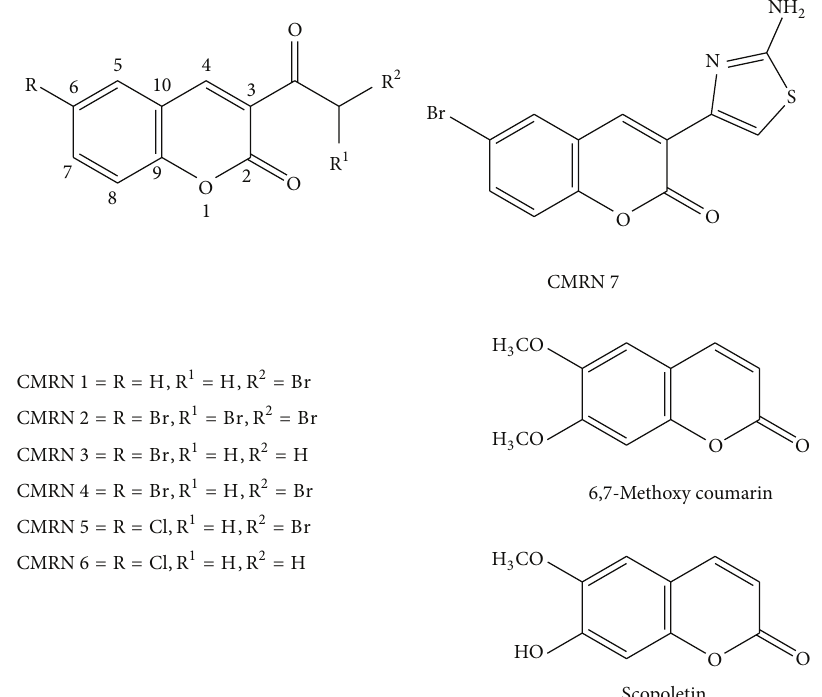
Figure 1: Synthetic halogenated coumarin compounds CMRN 1–CMRN 7, 6,7-dimethoxy coumarin, and scopoletin tested for antimosquito